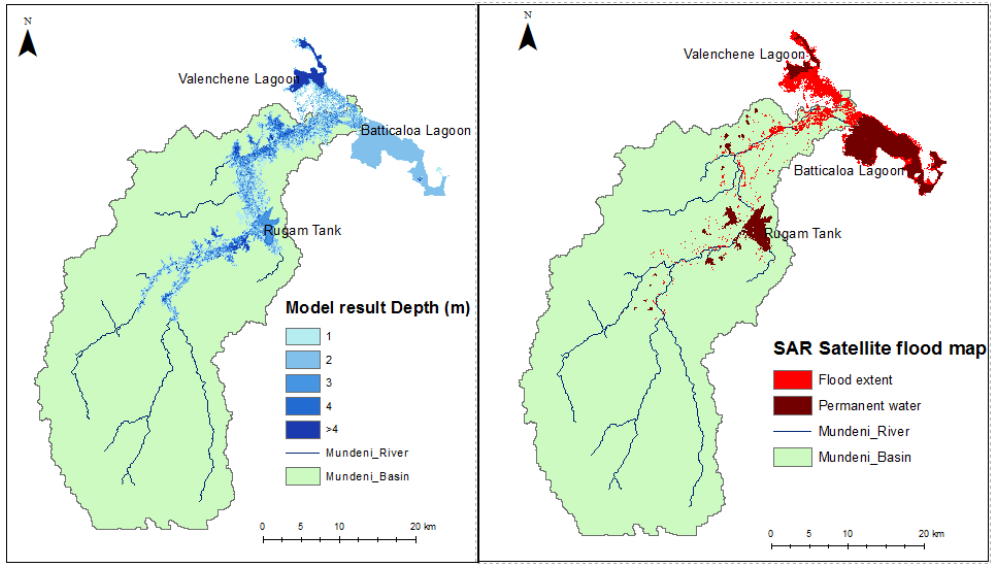
Figure 3. Flood inundation maps for the Mundeni Aru River Basin. Results from the LISFLOOD-FP model (left) and SAR satellite images